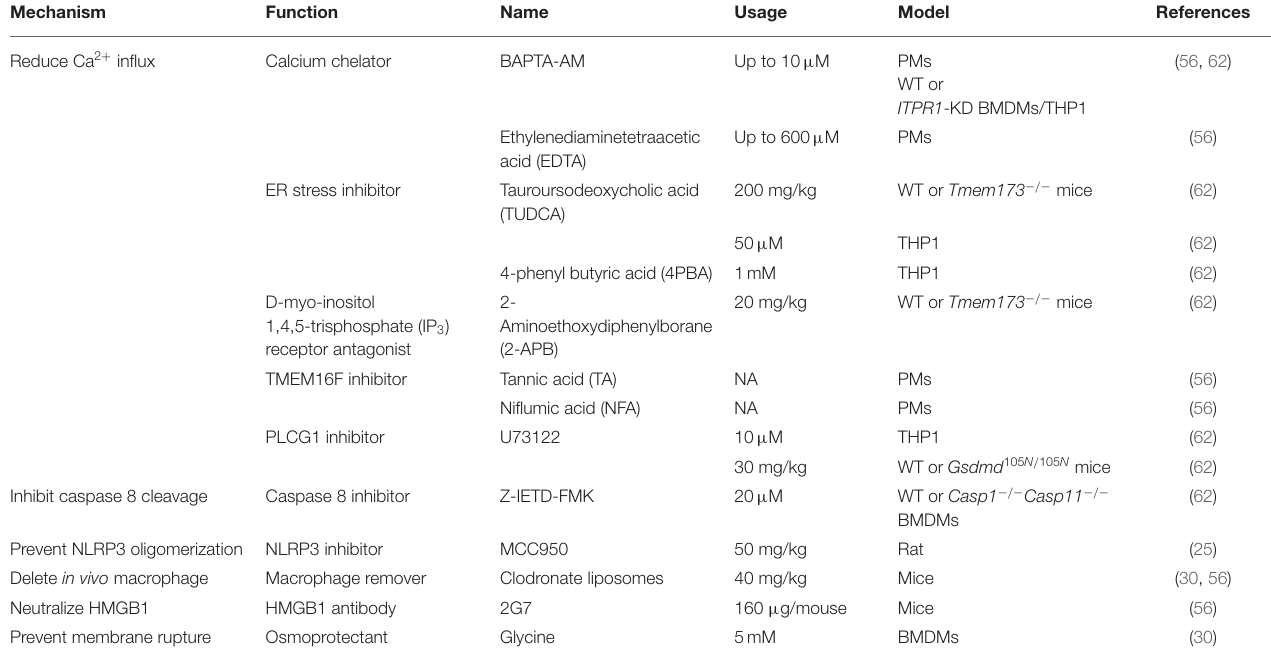
TABLE 1 | Potential inhibitors of inflammasome-dependent coagulation. Mechanism